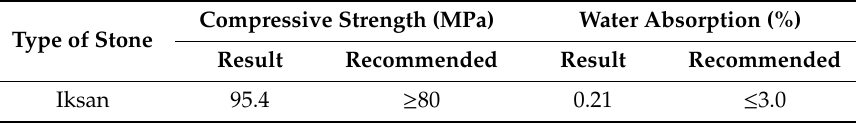
Table 7. The test result of natural surface stone (Han and Gong et al. [3]).